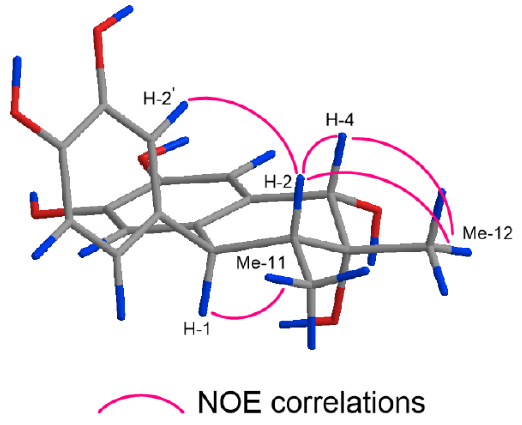
Figure 3. Key NOE correlations of 4 .